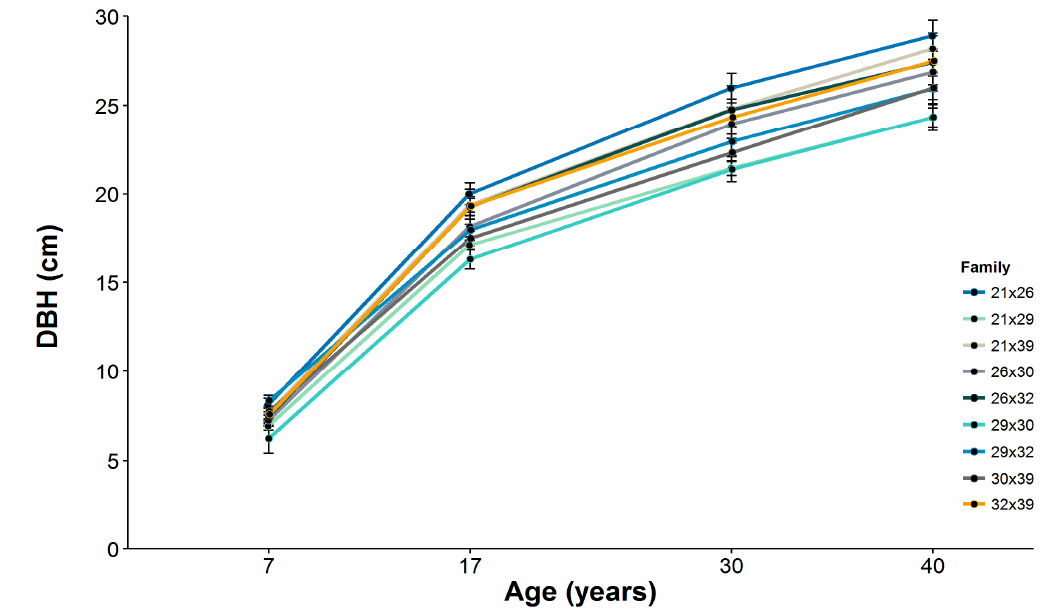
Figure 1. Family mean diameter at breast height (DBH) at ages 7, 17, 30 and 40. Vertical lines for each data point represent the standard error of the mean .